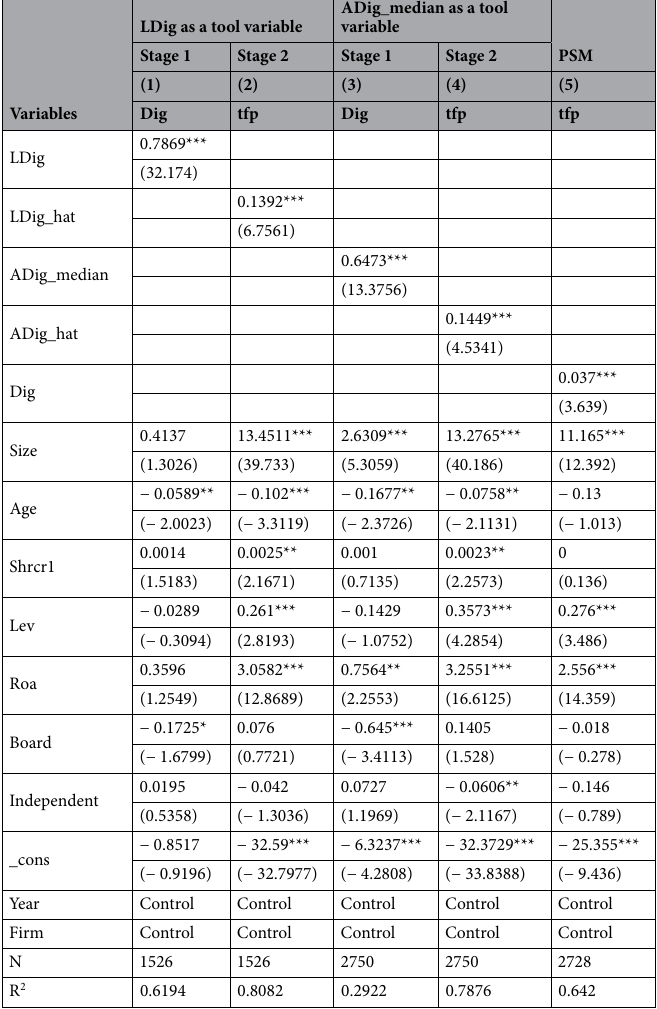
Table 5. Endogeneity tests: regression results of the instrumental variables method and PSM method. T-statistics are shown in parentheses. ***, ** and * indicate 1%, 5% and 10%